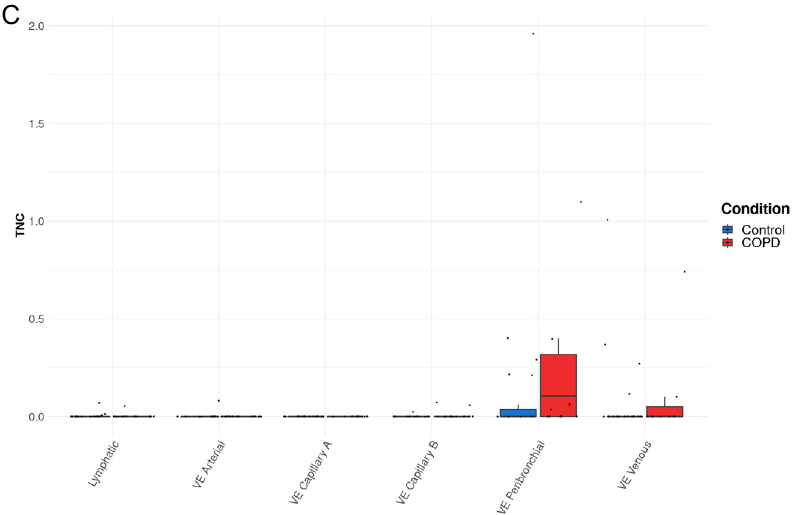
Figure 5. TNC expression is increased in AT2A cells and endothelial cells (peribronchial vascular endothelial cells) in COPD compared to control lungs. ( A – C ) TNC expression in parenchymal tissue explanted from the lung of patients with COPD or control donors generated from http://www.copdcellatlas.com (accessed on 1 Novmber 2022) [23].